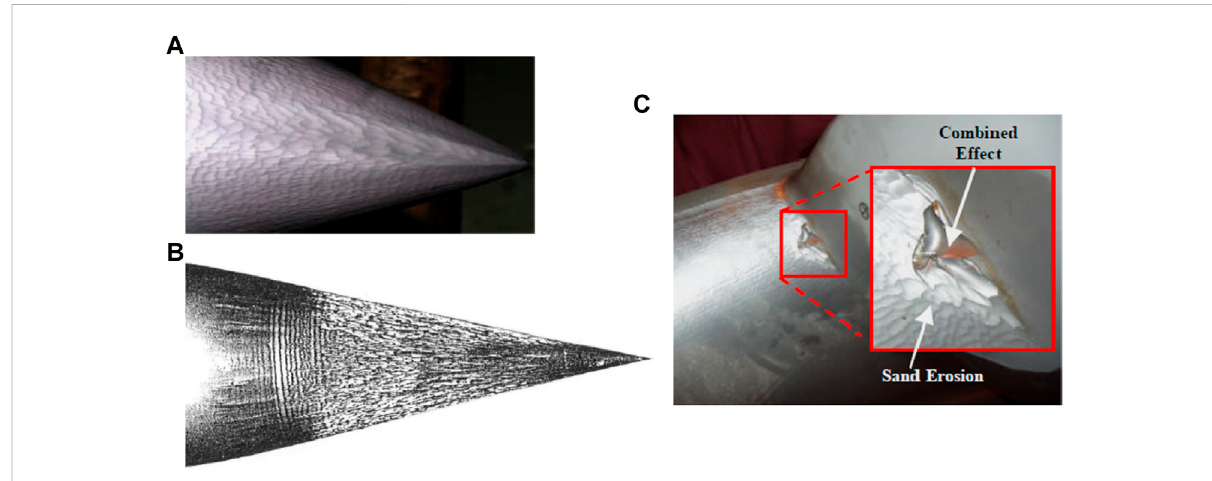
FIGURE 1 Erosion in the hydro turbine for (A) the needle with pure cavitation erosion, (B) the needle with synergy of cavitation and sand erosion, and (C) turbine runner with synergy of cavitation and sand erosion shown in the enlarged picture (Thapa et al., 2007).